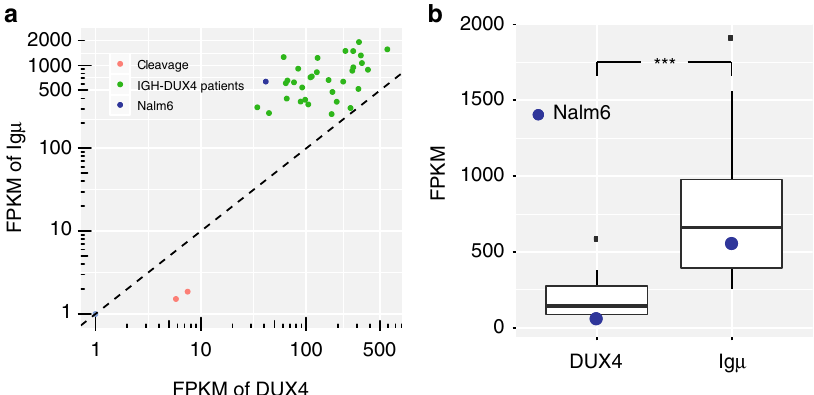
Fig. 1 Expression of the translocated DUX4 and Ig μ in IGH - DUX4 B-ALLs. a DUX4 and Ig μ expression in human embryonic cleavage cells, 32 IGH - DUX4 B- ALL patients, and Nalm6 cell line are shown in red, green and blue, respectively. b Box plot of DUX4 and Ig μ expression level in the 32 IGH - DUX4 B-ALL patients and Nalm6 cell line (blue dots). Median FPKM of DUX4 and Ig μ in 32 patients are 145.4 and 661.9, respectively. One-tailed, paired sample t -test was performed: *** p < 0.001. Boxes show the fi rst to third quartile with median, whiskers encompass 1.5 times of the interquartile range, and data beyond that threshold indicated as outliers